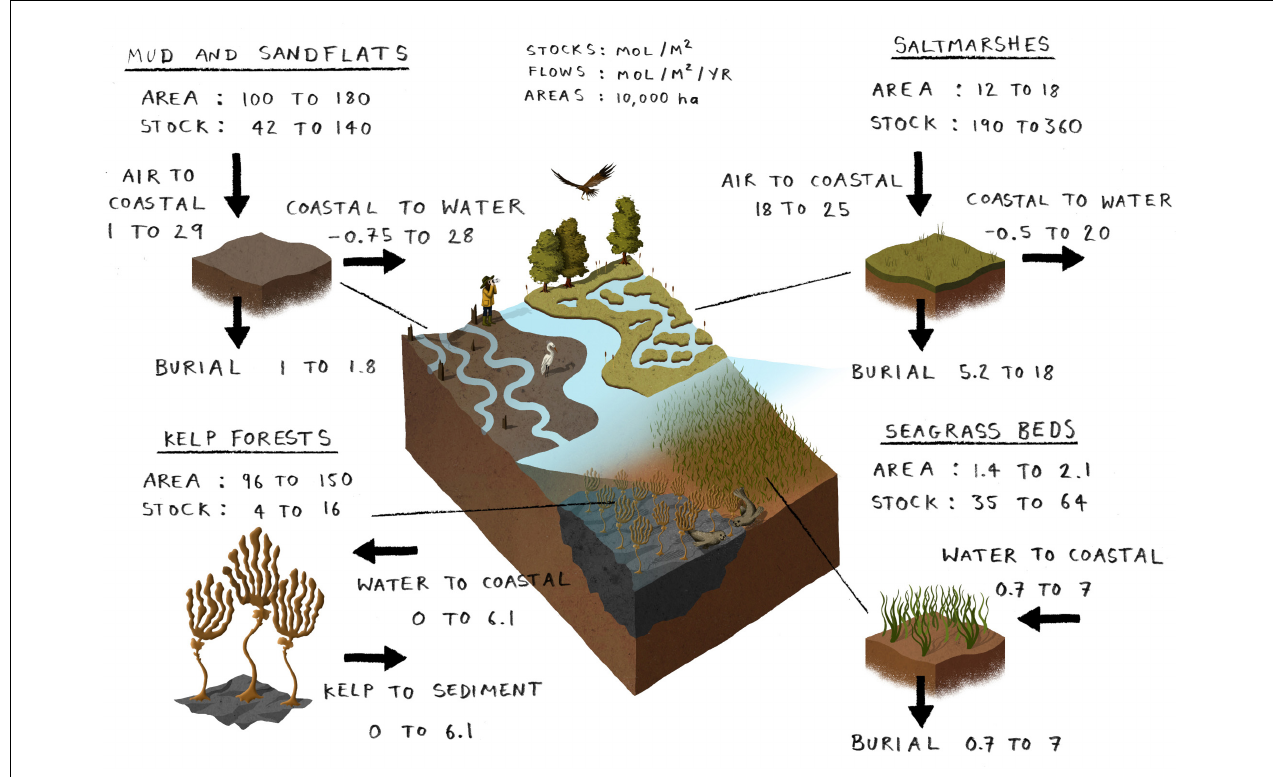
FIGURE 4 | A breakdown of the carbon budget in coastal habitats of the north west European shelf. Ranges are based on a synthesis of literature values. Saltmarshes: Boorman (2003), Wood et al. (2015), Dijkema (1991), Davidson et al. (1991), Skov et al. (2016), Thornton et al. (2002), Barillé-Boyer et al. (2003), Beaumont et al. (2014), Burrows et al. (2014), Luisetti et al. (2019), Mcowen et al. (2017), Artigas et al. (2015), and Houghton and Woodwell (1980). Mud and sand flats: Maddock (2008), Dijkema (1991), Barillé-Boyer et al. (2003), Thornton et al. (2002), Adams et al. (2012), Nedwell et al. (2016), Underwood et al. (2016), and Wood et al. (2015). Seagrass beds: Maddock (2008), Essink et al. (2005), Fourqurean et al. (2012), Burrows et al. (2017), and Duarte (2017). Kelp forests: Burrows et al. (2014), Krause-Jensen and Duarte (2016), and Krause-Jensen et al. (2018). Full synthesis details given in Supplementary Material Part A